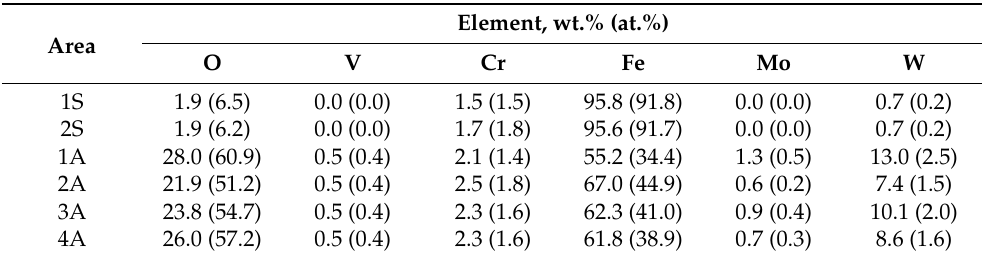
Table 8. EDS elemental composition of subsurface area on AISI 52,100 counterbody after sliding at 3.6 m/s (Figure